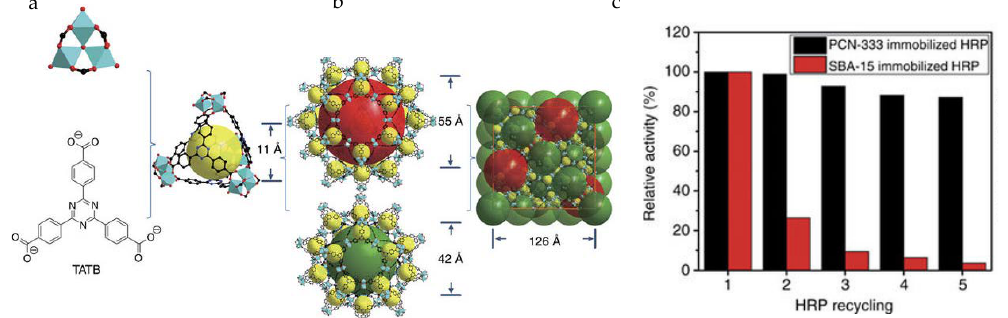
Figure 3. ( a ) Ligand and cluster used in PCN-333; ( b ) Three different cages in PCN-333; ( c ) Catalytic activity of immobilized enzymes in each recycle test [34]. Reproduced from [34] with permission from Springer Nature, copyright 2015.